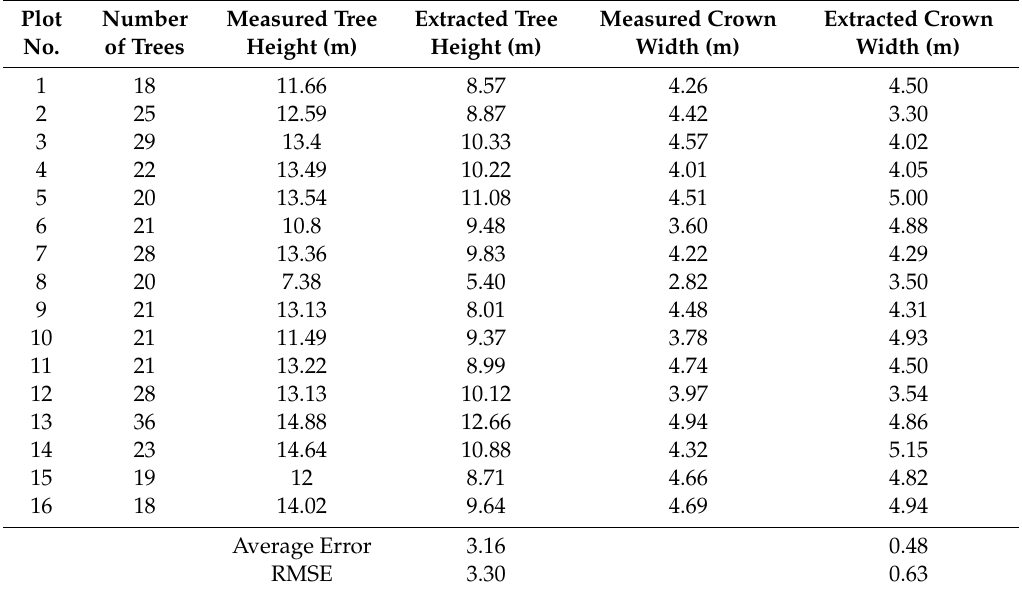
Table 7. The statistics of the tree extracted by template-matching algorithm (cosine) in 16 super plots. Plot